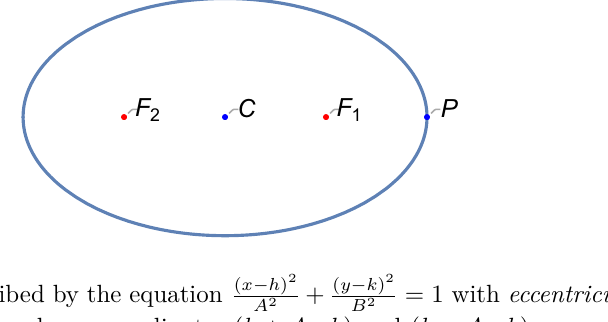
Figure 2. An ellipse described by the equation ( x − h ) 2